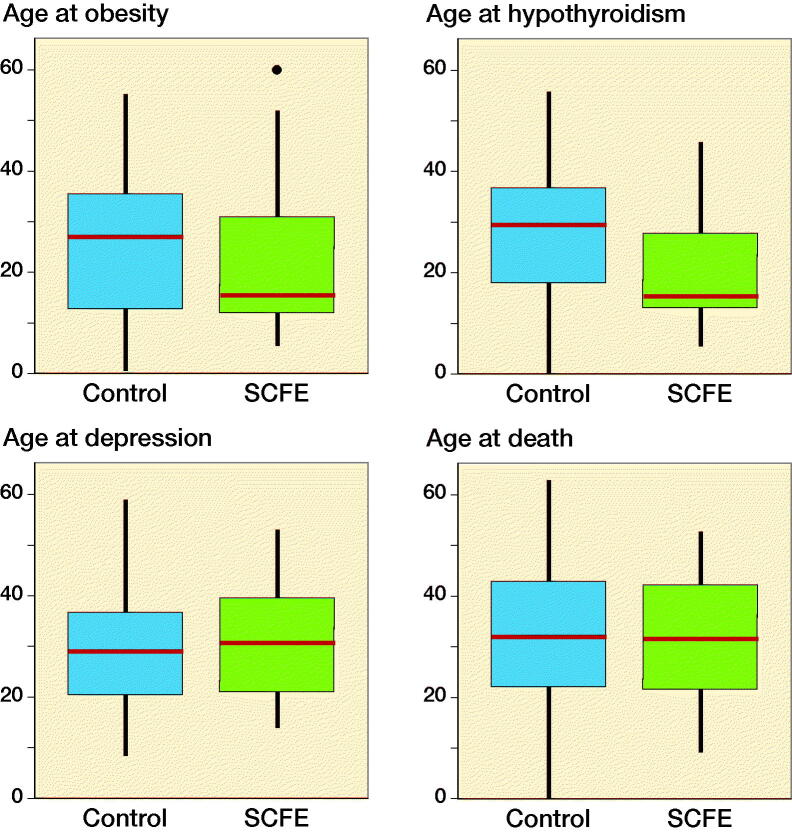
Age at onset of obesity, hypothyroidism, depression, or death of SCFE patients. Age at onset of the diagnosis of obesity and hypothyroidism is younger in patients with SCFE than in the control group (obesity: p-value < 0.05; hypothyroidism: p-value < 0.001). No differences were found for age at diagnosis of depression or death between the two groups. The boxes represent the interquartile range and the red line median. The whisker represents the age range at diagnosis or death.The dot represents an outlier.